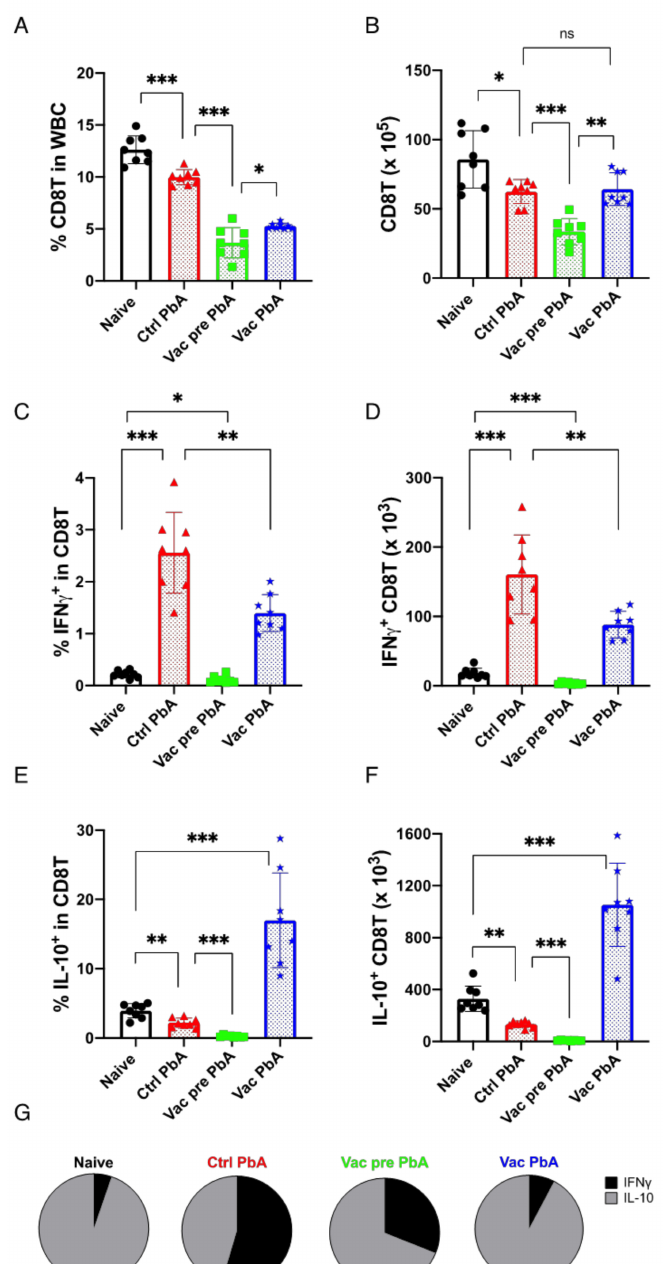
Figure 7. Live vaccination (Vac) tuned the balance between the pro- and anti-inflammatory response in splenic CD8 + T cells against P. berghei ANKA (PbA) challenge infection. Splenocytes from naive mice (N = 8; black circle), control (Ctrl) PbA mice infected on day 8 (N = 8; red triangle), Vac mice pre-infection at 40 days after vaccination with Plasmodium yoelii 17XNL (N = 8; green square), and Vac mice infected with PbA on day 8 (N = 8; blue star) were obtained to analyze intra-cellular cytokine production. ( A ) Proportion of CD8 + CD3 + (CD4T) cell in WBCs. ( B ) Absolute number of CD8T cells in the spleen. ( C ) Proportion of IFN γ -producing cells in CD8T cells. ( D ) Absolute number of IFN γ -producing CD8T cells in the spleen. ( E ) Proportion of IL-10-producing cells in CD8T cells. ( F ) Absolute number of IL-10-producing CD8T cells. ( G ) The ratio of IFN γ -producing CD8T cells (black) to IL-10-producing CD8T cells (gray). Data are pooled from 2 independent experiments. *: p < 0.5; **: p < 0.01; ***: p < 0.001; ns: not significant. Each symbol represents one mouse. Data represent the mean ± standard deviation (SD). p values were determined by two-tailed Student’s t